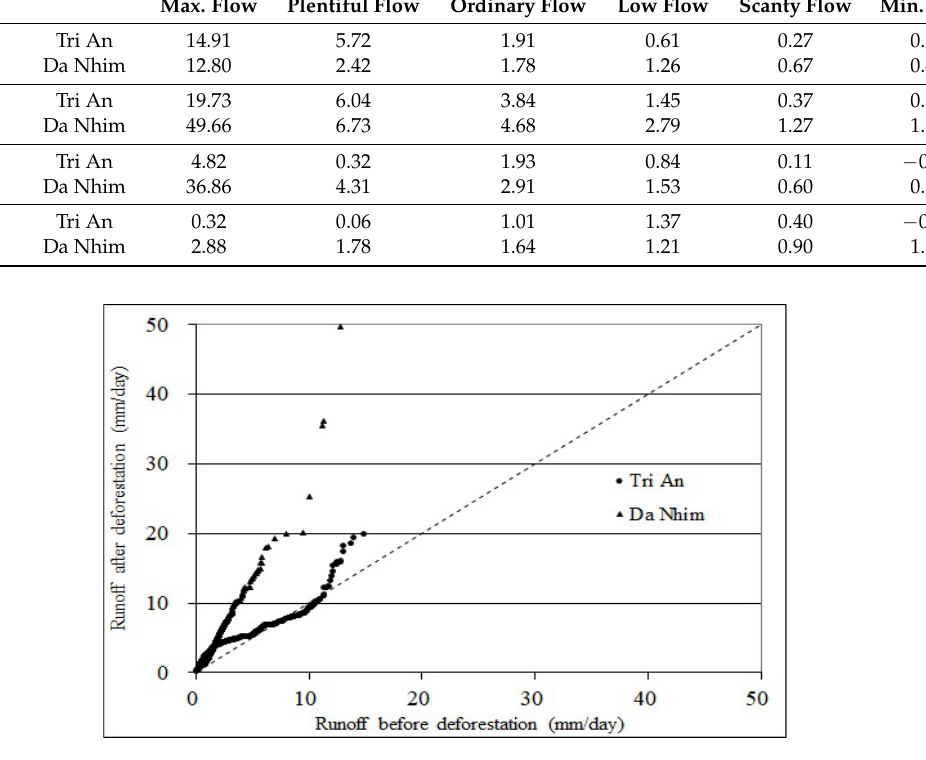
Figure 7. FDCs before and after deforestation of Tri An and Da Nhim.